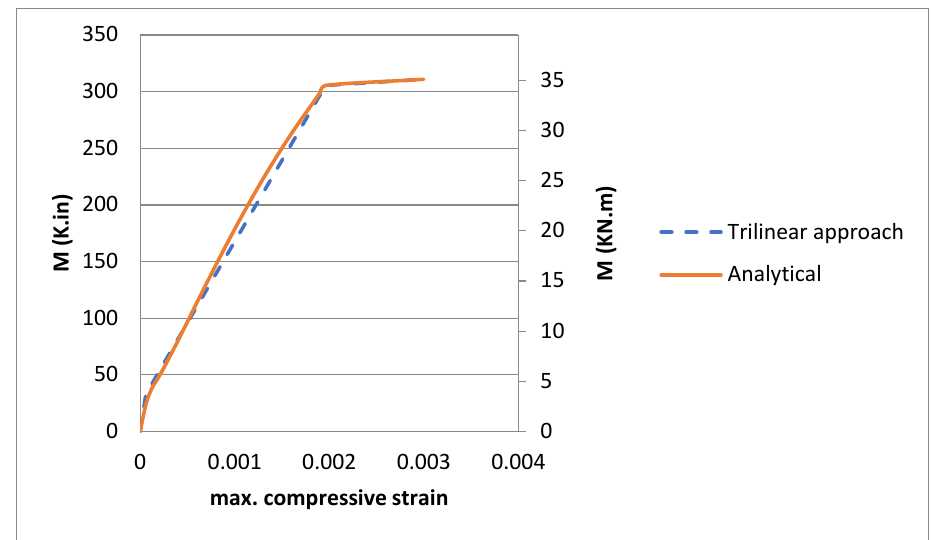
Figure 25. Almusallam (1997) [19] moment vs. maximum compressive strain analytical graphs.